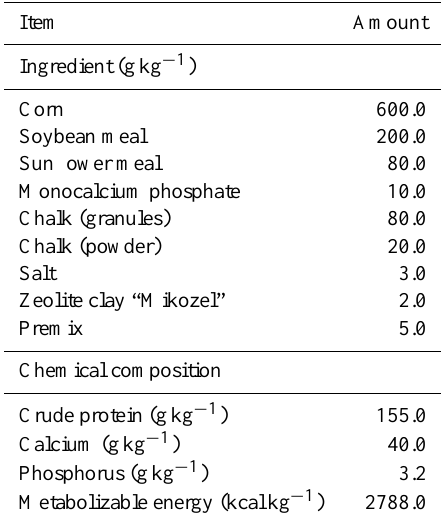
Table 1. Composition of feed of complete commercial feeding mix- ture for laying